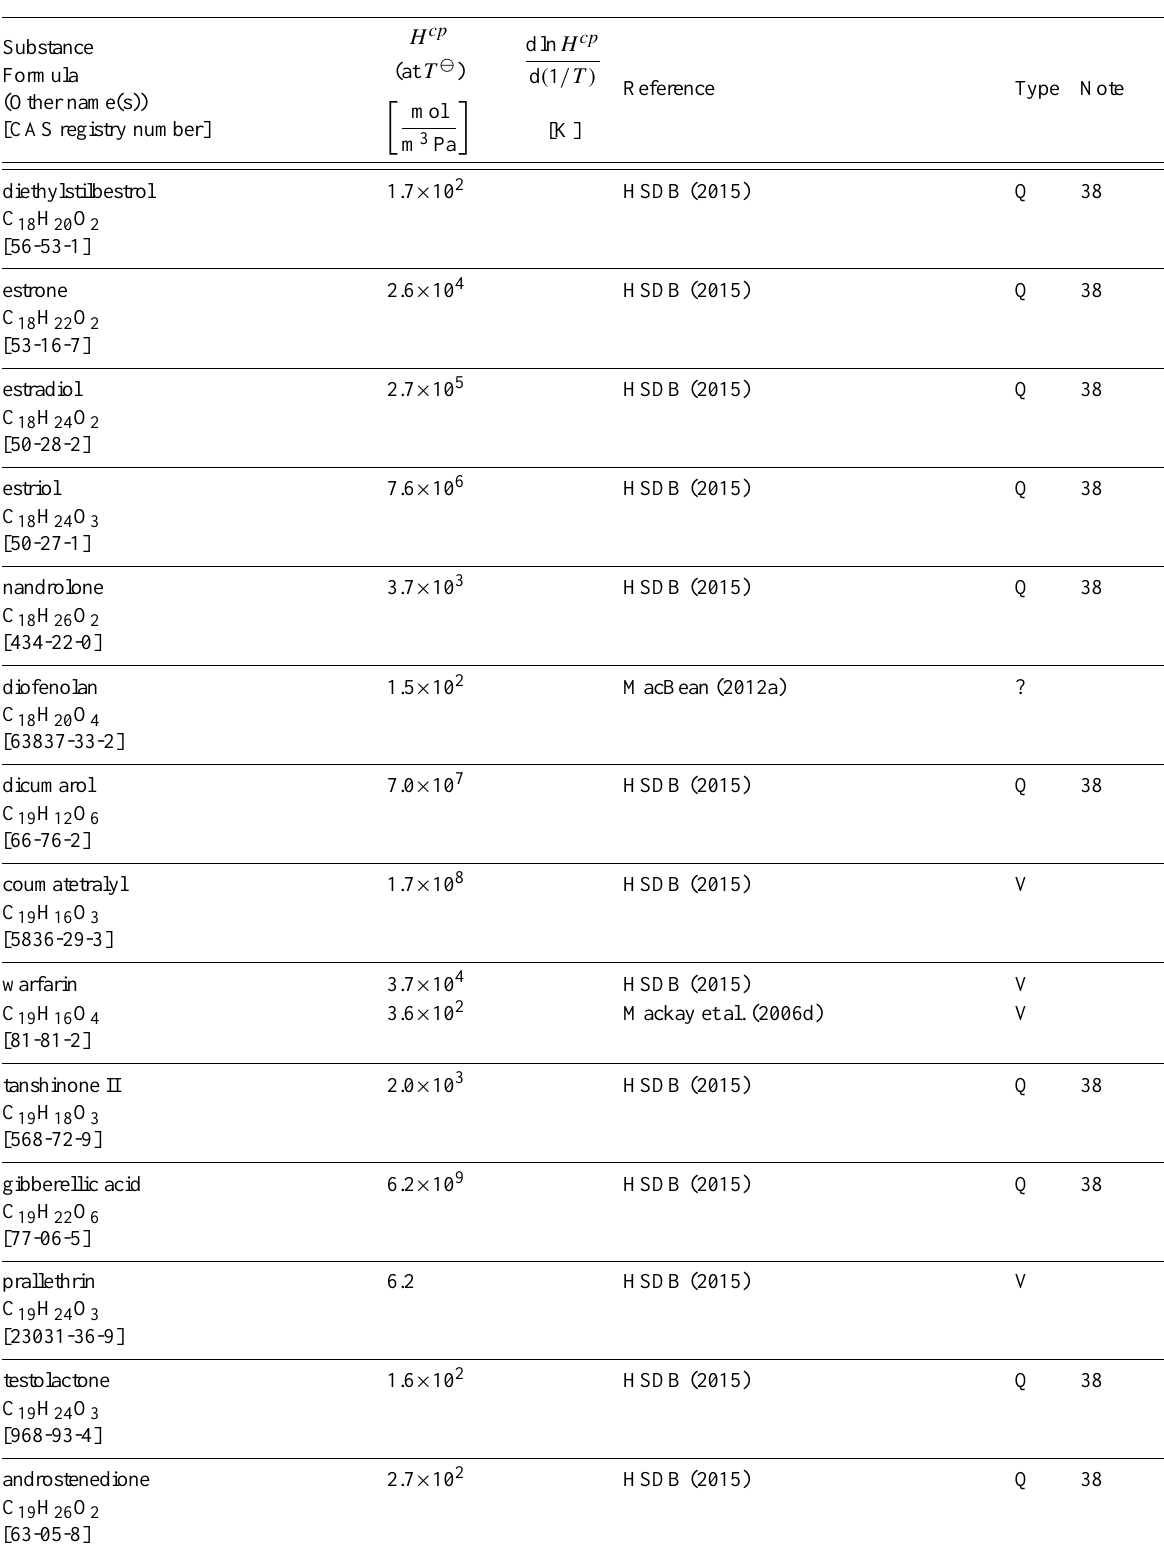
Table 6: Henry’s law constants for water as solvent